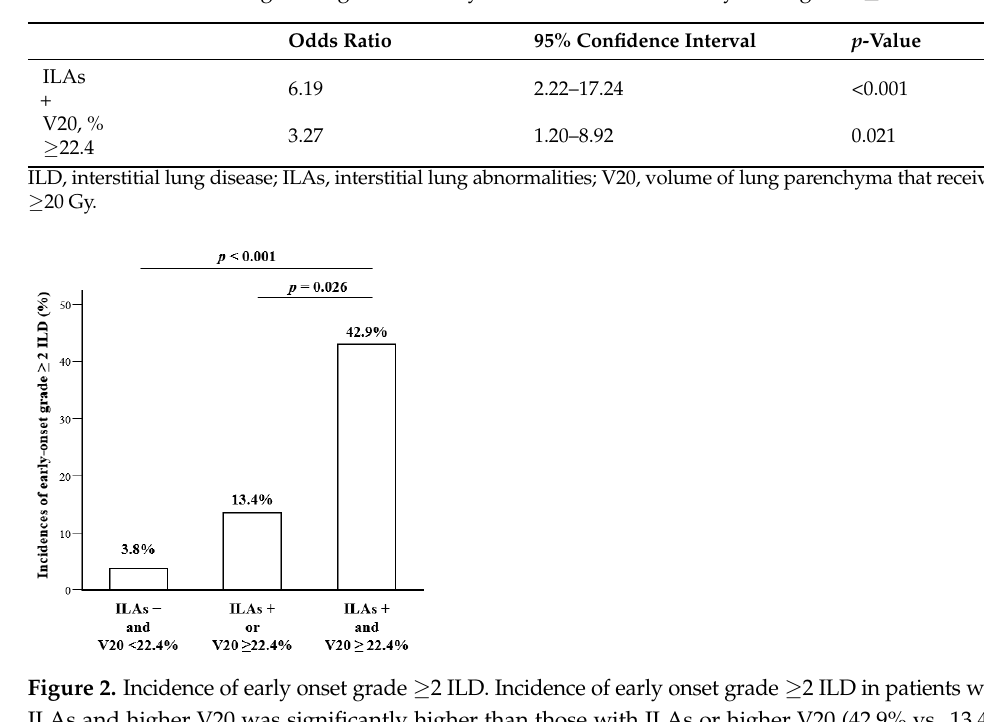
Table 7. Multivariate logistic regression analysis of risk factors for early onset grade ≥ 2 ILD.